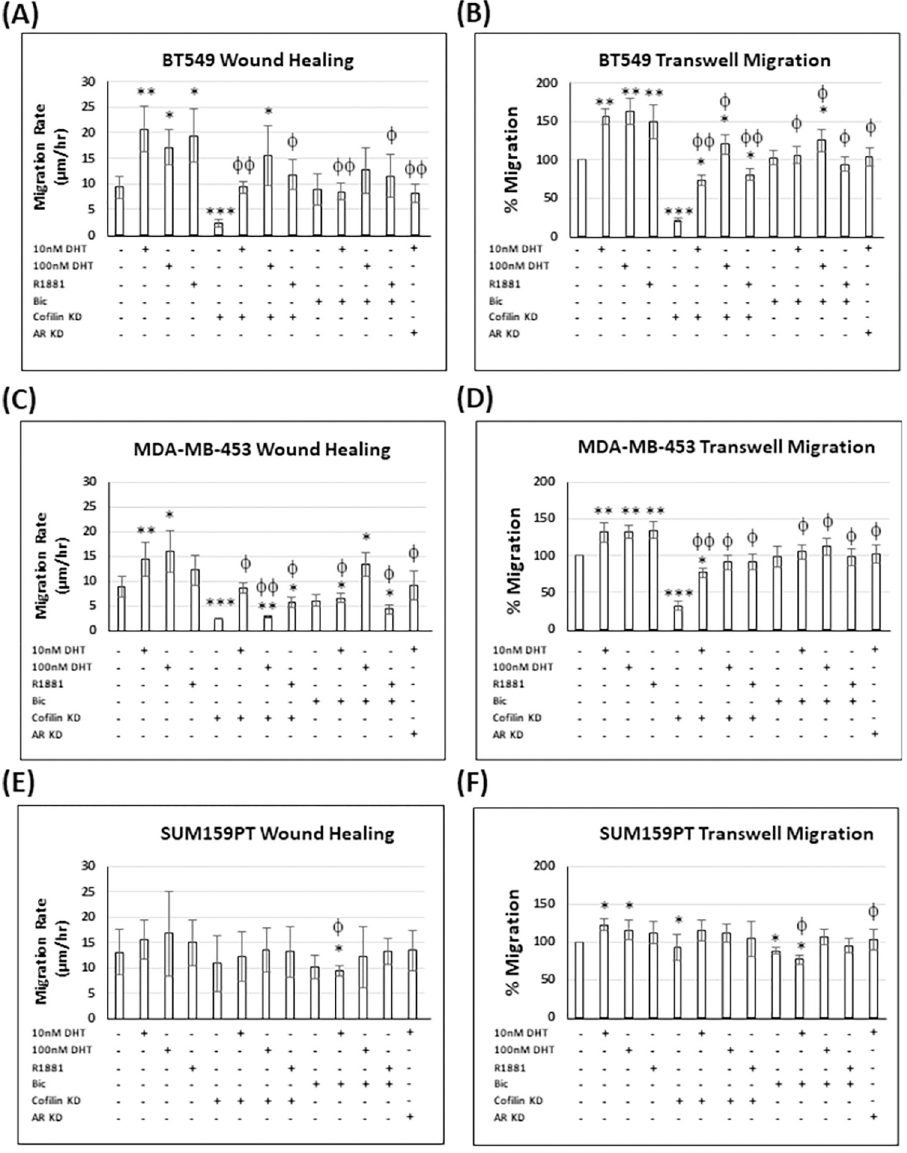
Fig 9. Androgens increase BT549 and MDA-MB-453 wound healing and transwell cell migration rate, while knocking down cofilin reduces it in the three TNBC cell lines. TNBC cells (A) BT549, (C) MDA-MB-453, and (E) SUM159PT were grown into monolayers and wounds were made with a sterile tip. The wound area was measured at 0 hr and later at 10–12 hr, and migration rate was expressed as μ m/h. Additionally, cells [BT549 (B), MDA-MB-453 (D), and SUM159PT (F)] were serum-starved, seeded on collagen I-precoated filters and then subjected to transwell migration assay. Cell migration is expressed as percent of control cells. Three independent experiments each performed in triplicate. � p < 0.05, �� p < 0.01, ��� p < 0.001 versus control, ϕ p < 0.05, ϕϕ p < 0.01 versus